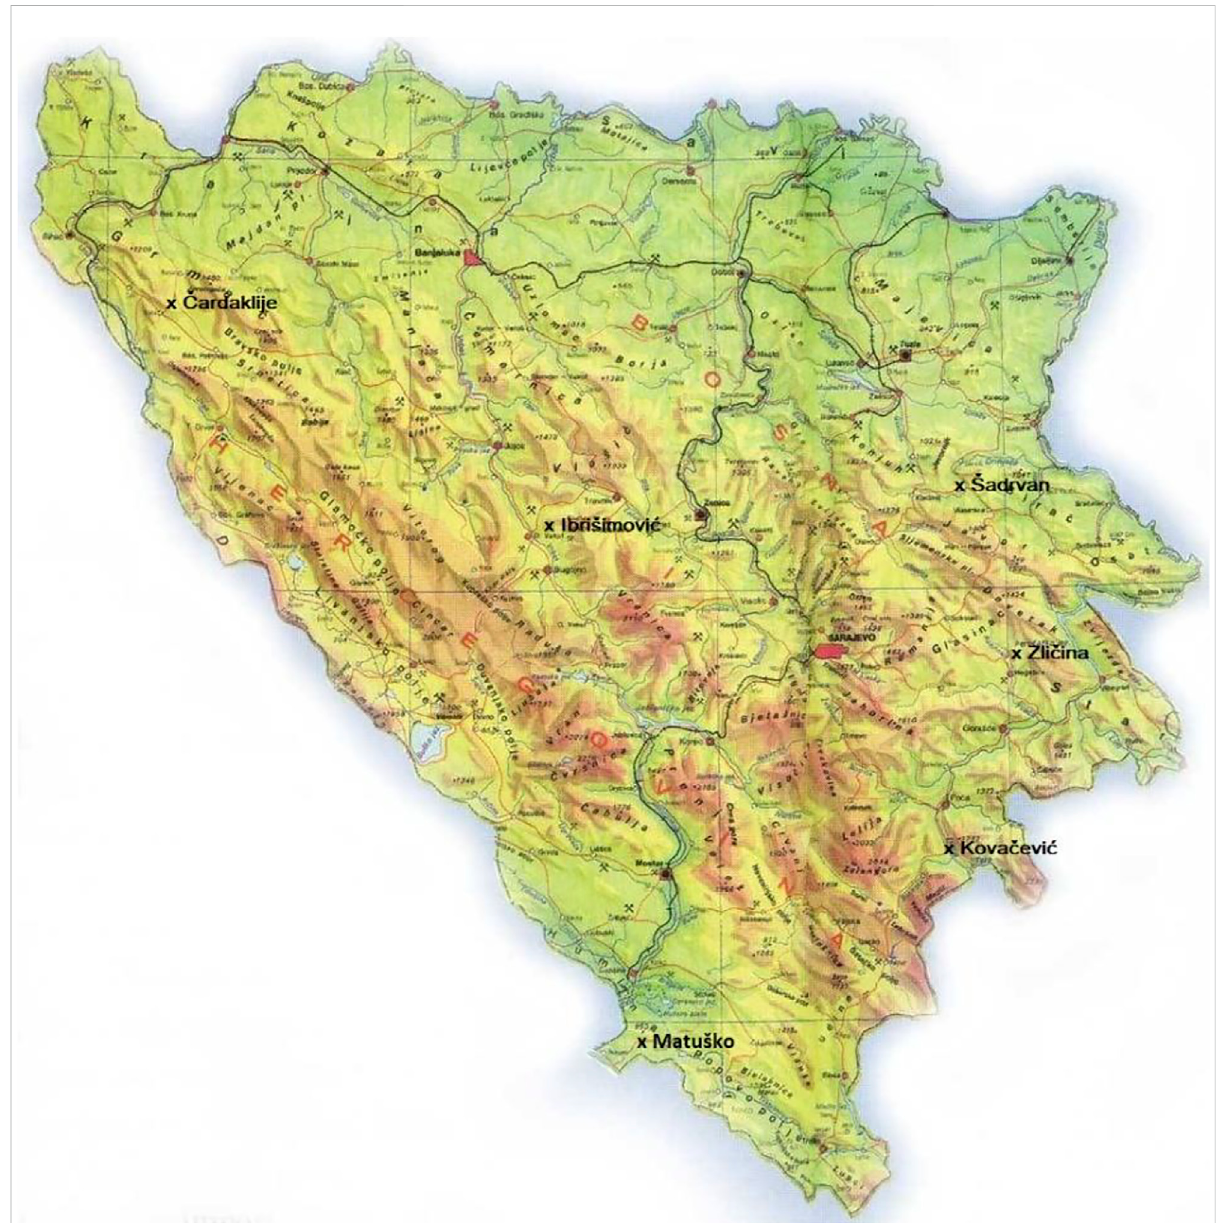
FIGURE 1 Area of the reviewed agritourism facilities in BiH. Source: authors ’ own processing based on Te š anj (2022).